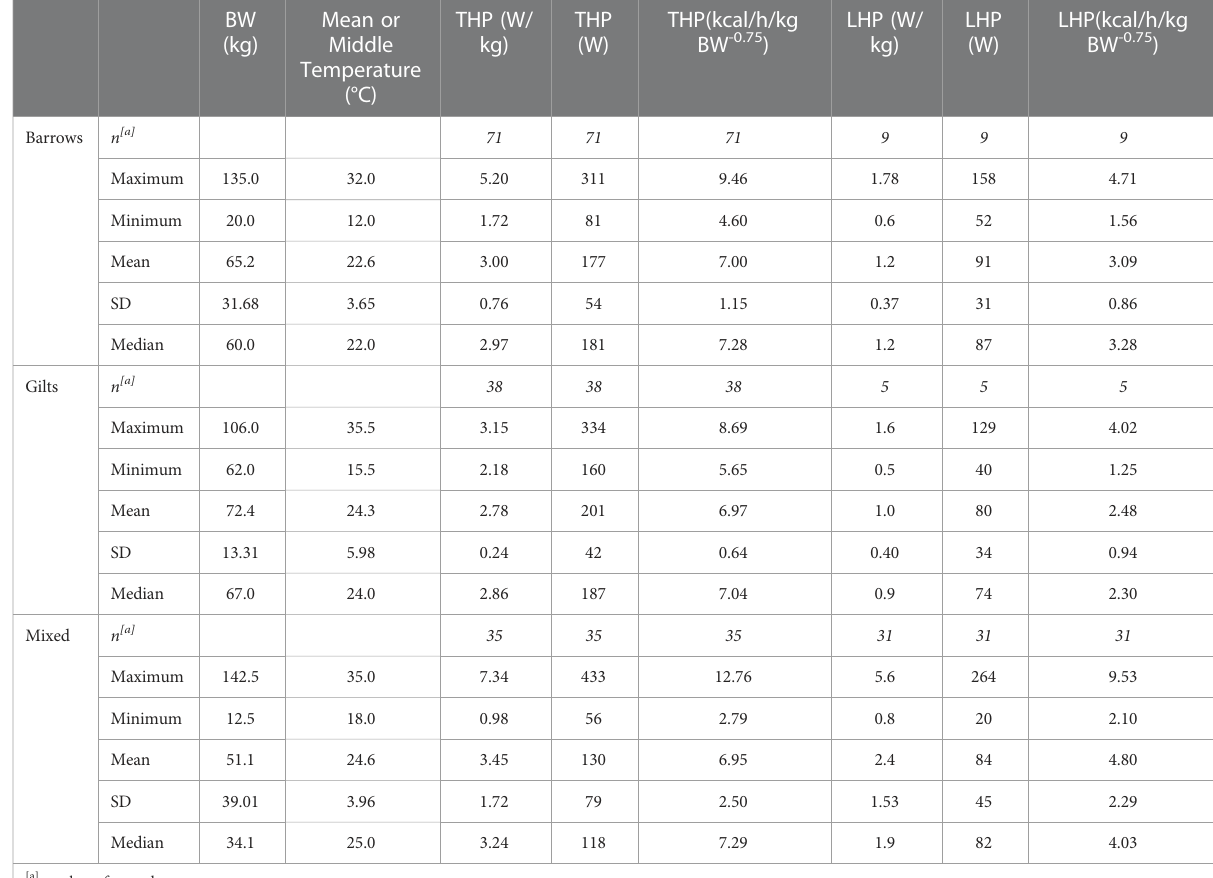
TABLE 2 Summary statistics for latent heat production from growing